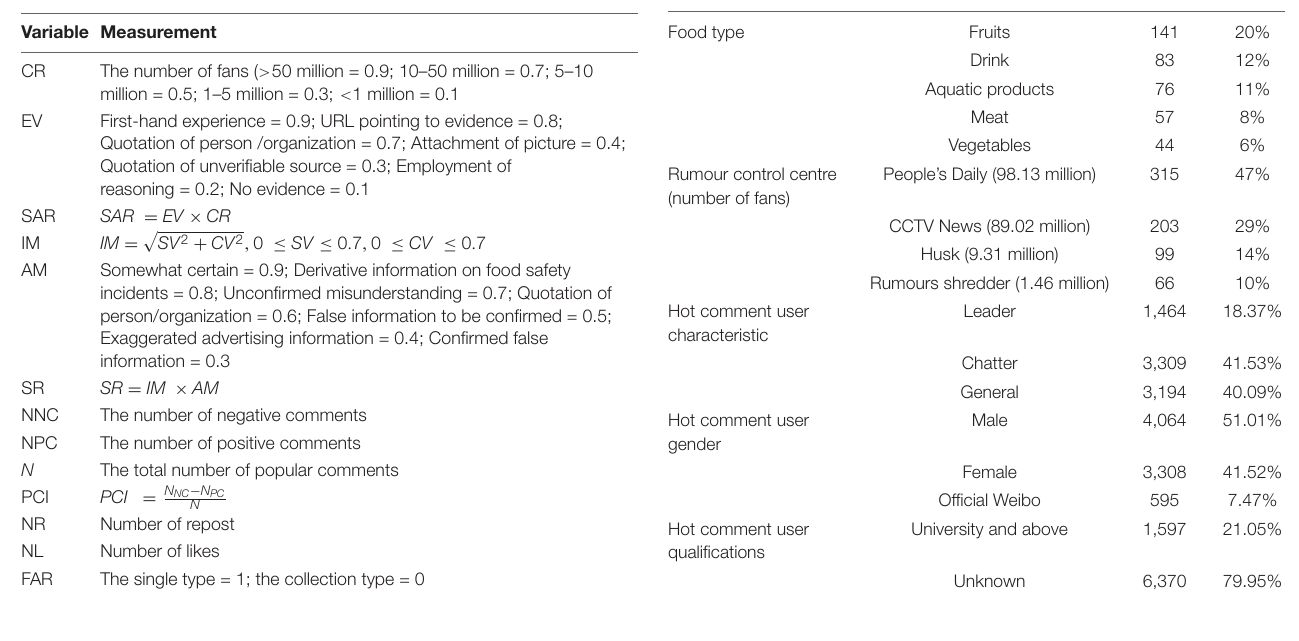
TABLE 5 | Measurement of variables.